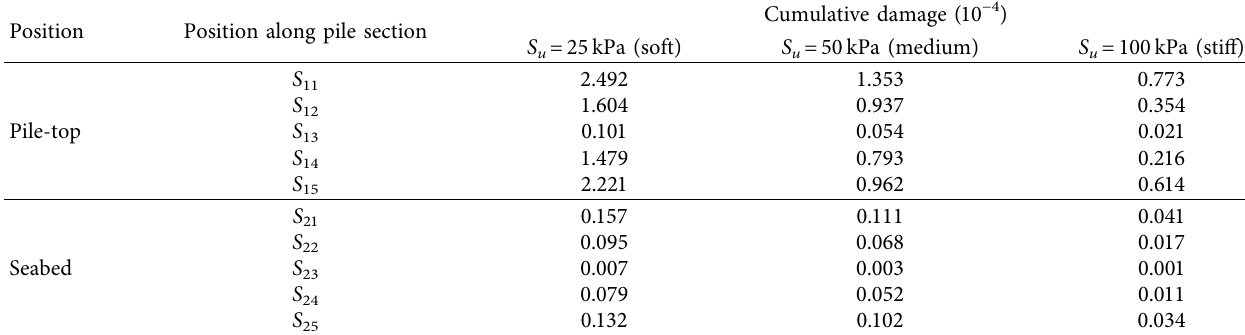
Table 2: 500 s cumulative fatigue damage with different soil conditions (water depth: 30m).